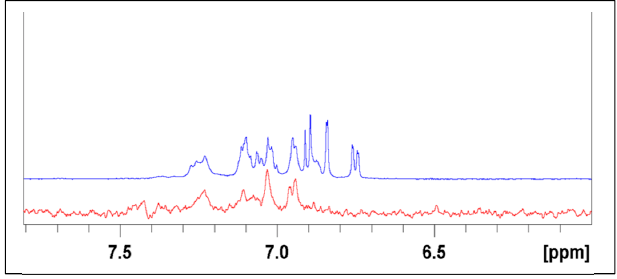
Figure 5. Comparison of aromatic proton sector of normal NMR spectrum ( blue ) with a DOSY section ( red ) taken in the correspondence of the polymeric chain signals.